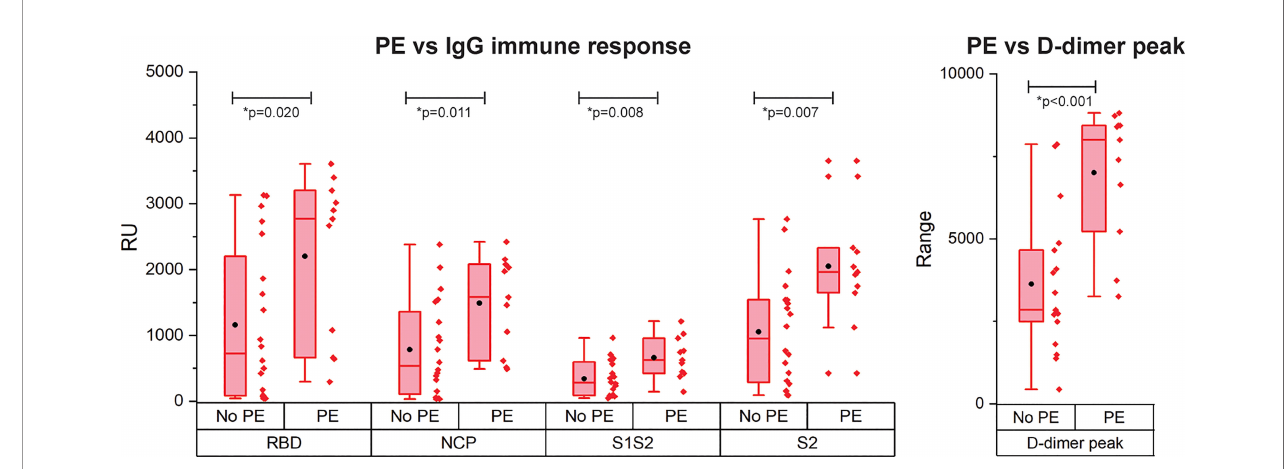
FIGURE 4 | Occurrence of pulmonary embolism (PE) in IgG immune response measurement for patients with critical disease and the D -dimer peak values. N= 28 patients. The boxplot represent the median, p25 and p75 values and the black dot the mean SPRi RU